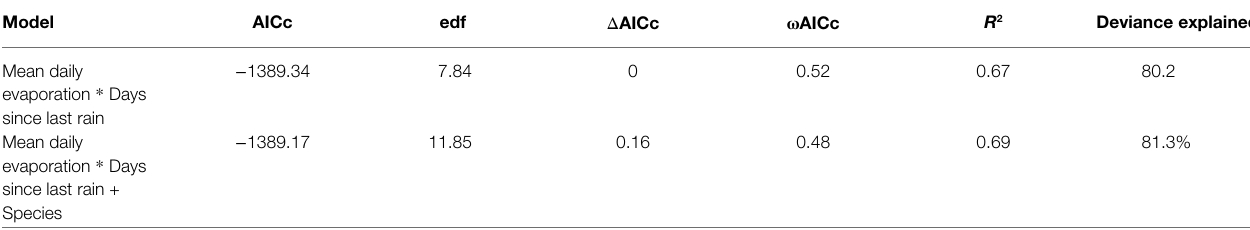
TABLE 2 | Top generalised additive models (GAMS; Δ AICc < 2) from full subsets analysis describing the patterns in seed water